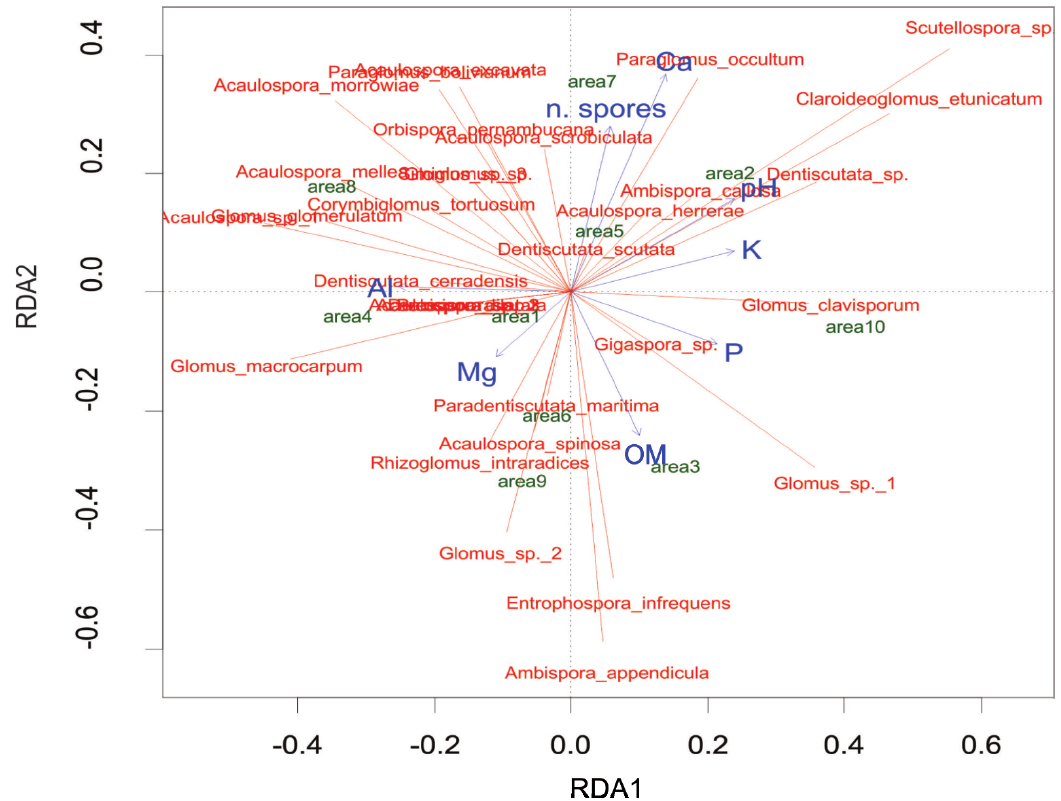
Figure 3 - redundancy analysis (rDA) for the soil chemical and physical characteristics, the number of spores and the arbuscular mycorrhizal fungal species, of all studied areas. Areas 1, 2 and 3 are of conventional cotton production systems; areas 4, 5 and 6 are of native Cerrado biome vegetation; areas 7 and 8 are of colored cotton family organic farming systems, and areas 9 and 10 are of native subcaducifolia